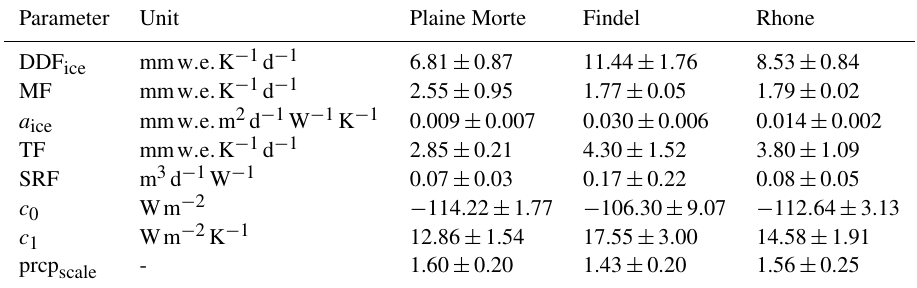
Table 2. Sample mean and standard deviations for the prior parameter distributions used on Glacier de la Plaine Morte, Findelgletscher, and Rhonegletscher. For a definition of the listed parameters, refer to Eqs. (7), (8), (9), and (12). Parameter Unit Plaine Morte